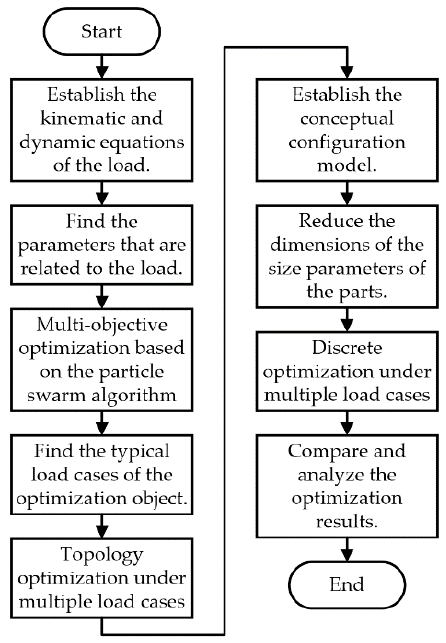
Figure 14. Flow chart of the